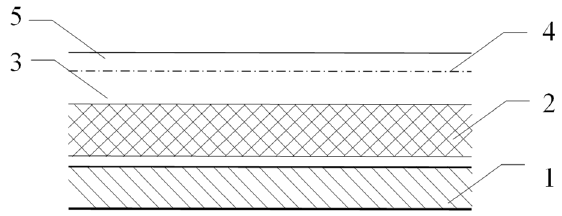
Figure 1. Schematic draft of non-adhesive flat extruded board system. 1. decorative layer; 2. steel wire mesh; 3. fine aggregate concrete protective layer; 4. thermal insulation and sound insulation layer (XPS); 5. floor structure layer (including leveling treatment).